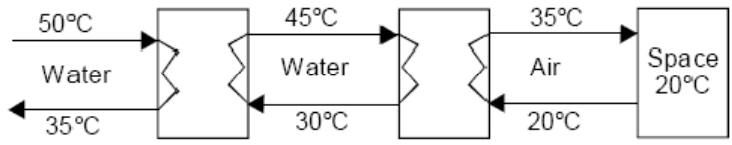
Figure 7. Space heating 15/10/5 rule with geothermal isolation plate heat exchanger (modified from Rafferty [25]). Supply air to space air = 15 °C; Water/air heat exchanger = supply water to supply air of 10 °C; Water/water heat exchanger = supply water to supply water of 5